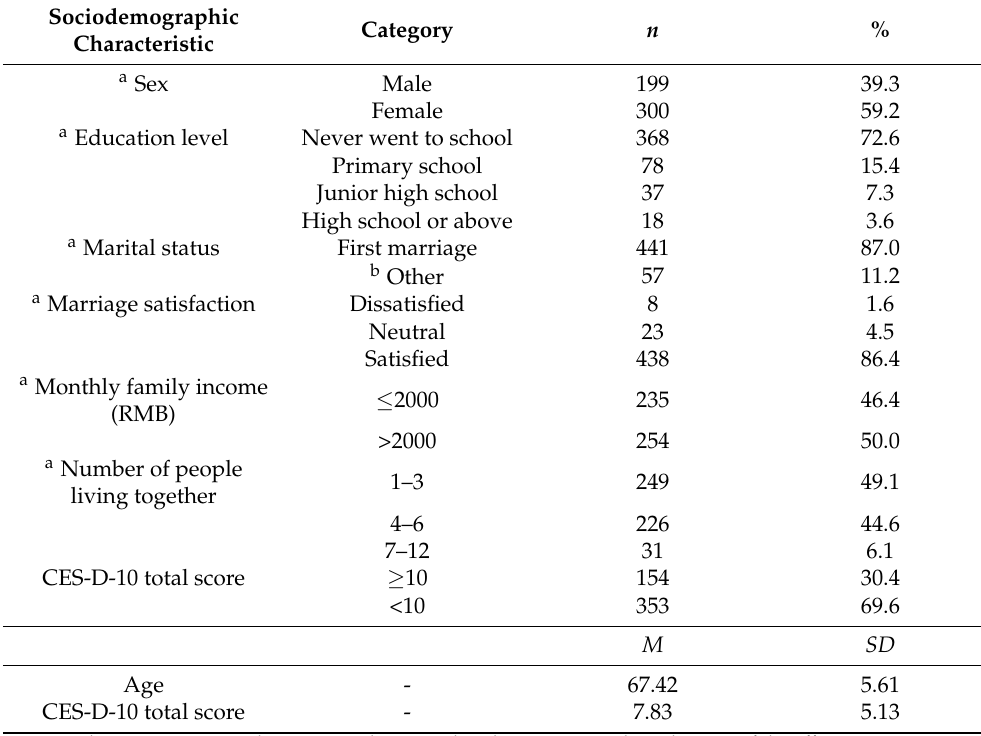
Table 1. Sociodemographic characteristics of the participants ( n =